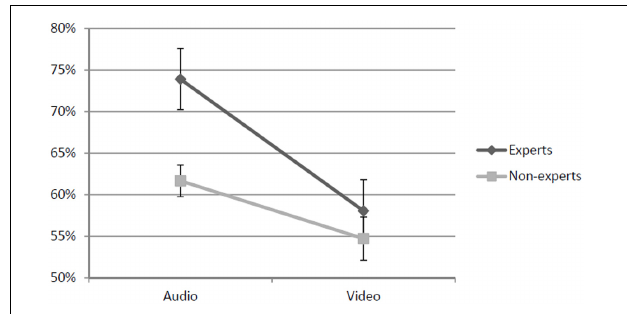
FIGURE 2 | Graphic representation of the results. This graph shows the percentage of accurate responses in the auditory and visual conditions, both for experts and non-experts. Error bars indicate standard